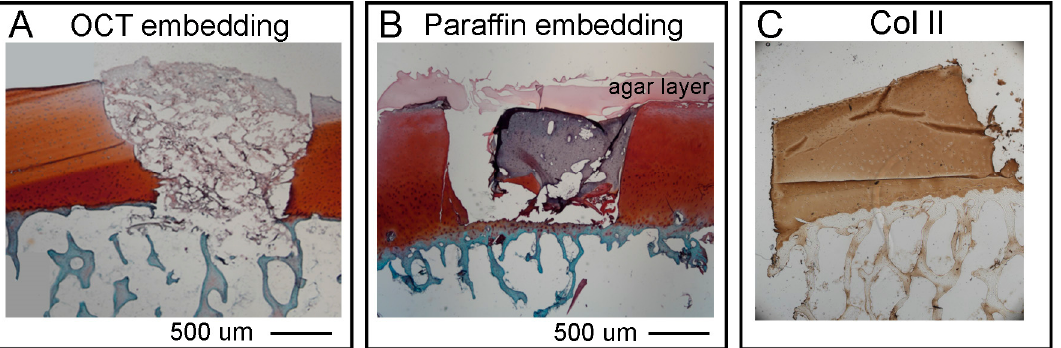
Figure 5. Comparison of 2 different histological embedding procedures on OC plugs cast with hydrogel material. A GelMA/HAMa hydrogel was used as an example. ( A , B ) Representative brightfield images of Safranin, Fast Green, H&E stainings performed on either cryo or agar/paraffin embedded samples. Scale bar 100 um corresponds to 100 µ m. ( C ) Representative image of anti-Collagen type II immunohistochemistry performed on 10 µ m section after cryo-embedding